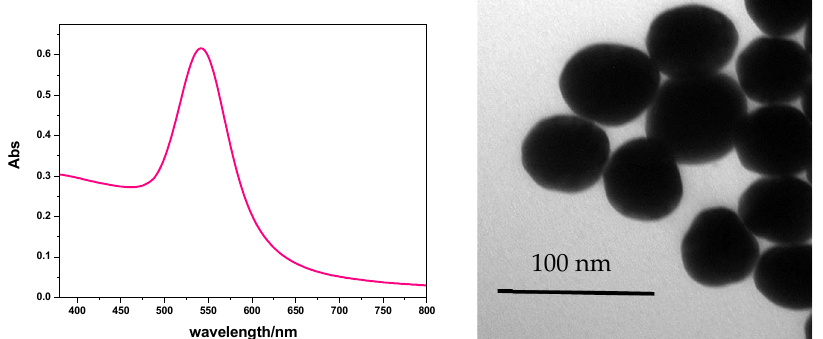
Figure 1. UV–Vis extinction spectrum and TEM image of Fig.1 UV-Vis extinction spectrum and TEM image of AuNS@PEG-SH Table 1. E. Coli UFC/mL exposed to different concentrations of AuNP, with and without the irradiation, and the percentage of growth inhibition after 24 hours of growth in incubator. No changes are recorded for the control ( E. Coli UFC/mL 2.1x10 8 with and without irradiation). Fig.2 Secondary electrons (on the left) and backscattered electrons (on the right) paired images demonstrating the uptake of AuNP in both non-irradiated (A, B) and irradiated (C, D) E. Coli cells. Irradiated E. Coli cells show greater pleomorphism (rough surface) and shrink in size because of increased cell death. Large aggregates of AuNP adhere onto the cell surface . Dark condition